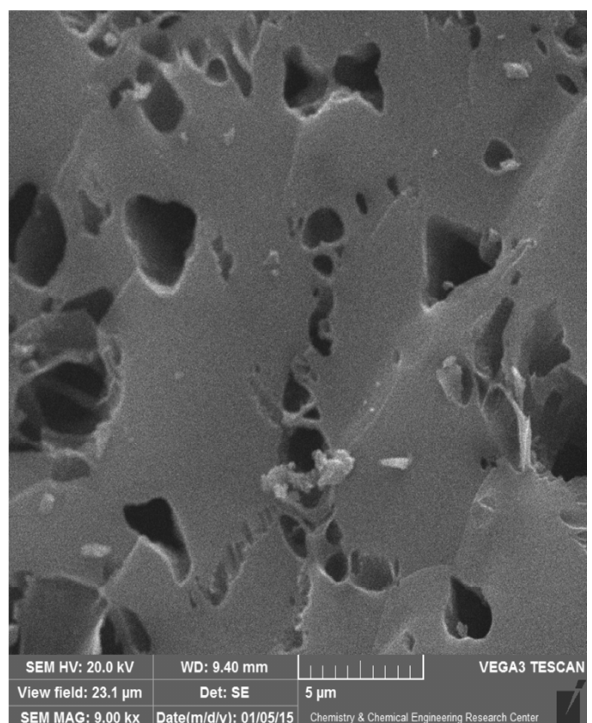
Figure 1. Scanning electron microscopy (SEM) image of activated carbon (AC)